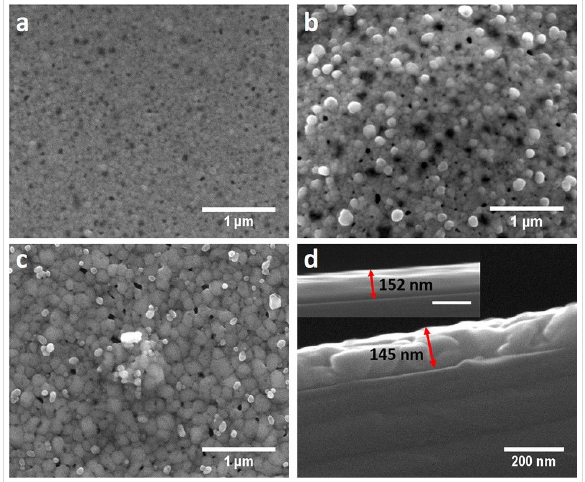
Figure 2: SEM image of a 200 nm sputtered silver film treated with hydrogen plasma (g12-p200) for (a) 5 min, (b) 30 min (taken at 45° tilt) and (c) 45 min at 100000× magnification showing the formation of etched holes and increasing grain structure of the silver film. (d) Cross- sectional SEM image of a 200 nm sputtered silver film after 30 min of hydrogen plasma treatment (g12-p200) depicting the actual lowered thickness of the hydrogen plasma-treated silver films compared to the as-sputtered silver film seen in the inset (scale bar: 200 nm). The blue arrow indicates a hole in the hydrogen plasma treated silver film.